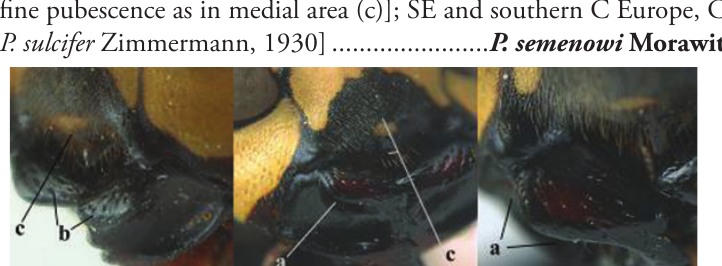
Basal half of mandible distinctly angulate (a) and flattened (b); clypeus gradu- ally depressed ventrally (c); [yellow area along inner eye margin connected to yellow bar above antennal sockets; clypeus largely punctate ventrally and with fine pubescence as in medial area (c)]; SE and southern C Europe, C Asia [= P. sulcifer Zimmermann, 1930] ....................... P. semenowi Morawitz, 1889